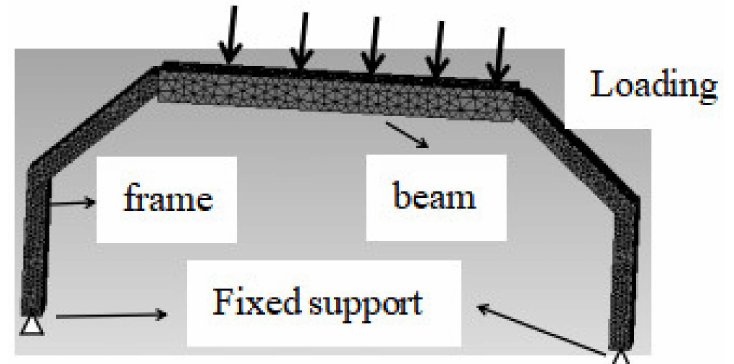
Figure 5. Simulation